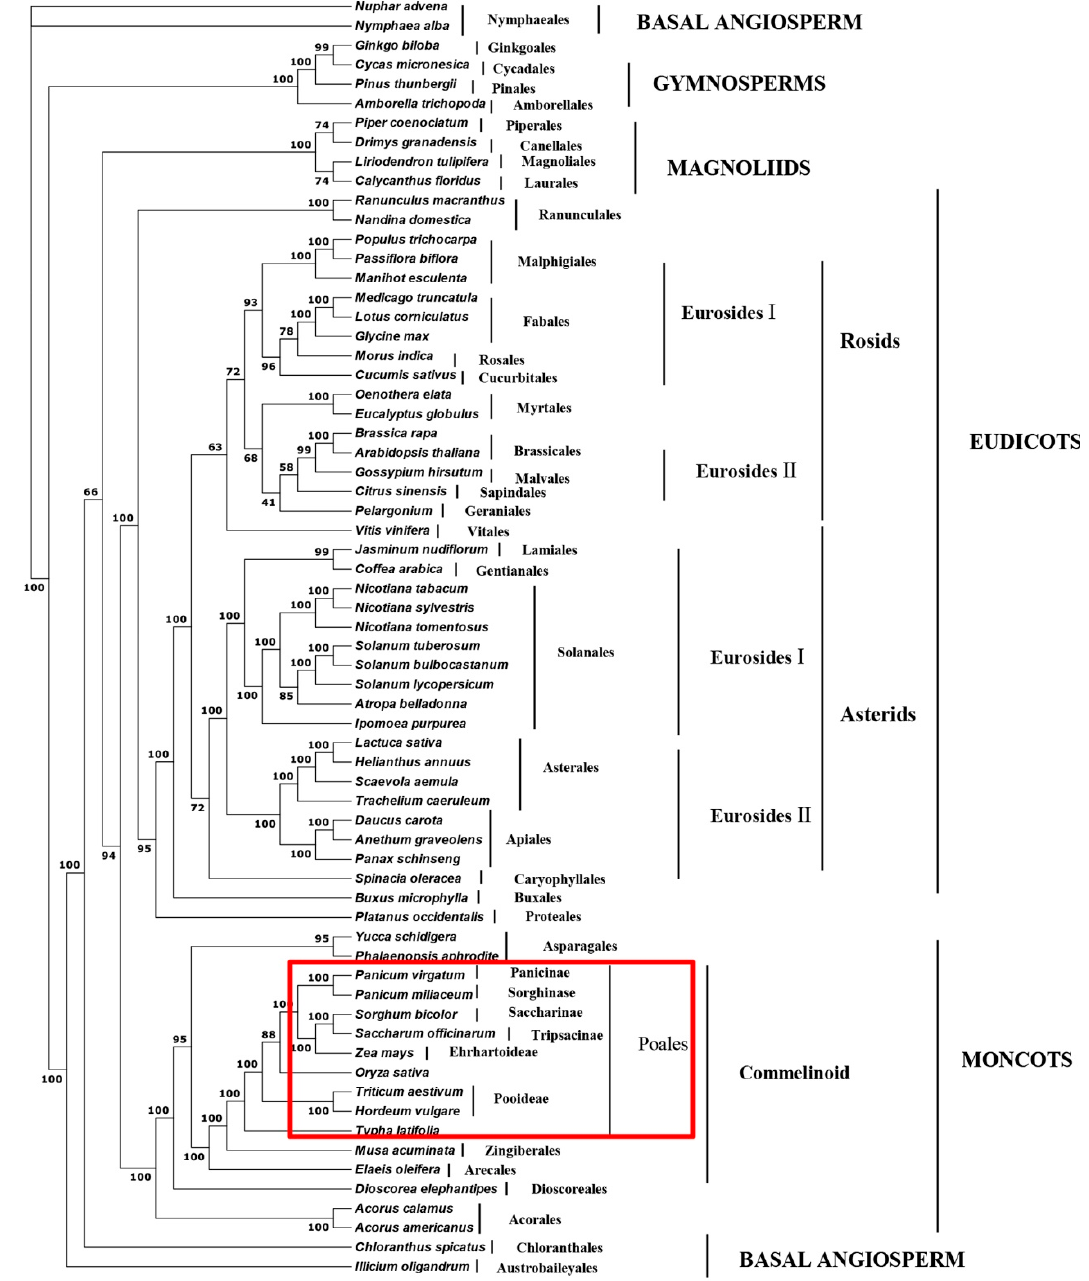
Figure 6. The MP phylogenetic tree is based on 81 genes from 66 plant taxa. The MP tree has the length of 146741and consistency index of 0.3838, and retention index of 0.6016. The numbers above the node are the bootstrap support values. The ML tree, which has the same topology, is not shown.